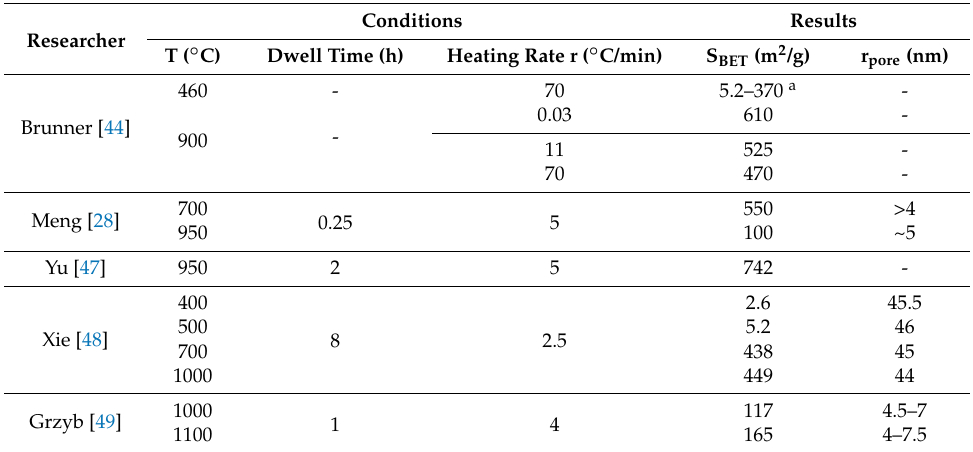
Table 1. Effect of temperature, dwell time, and heating rate on carbonized cellulose-based precursors reported in